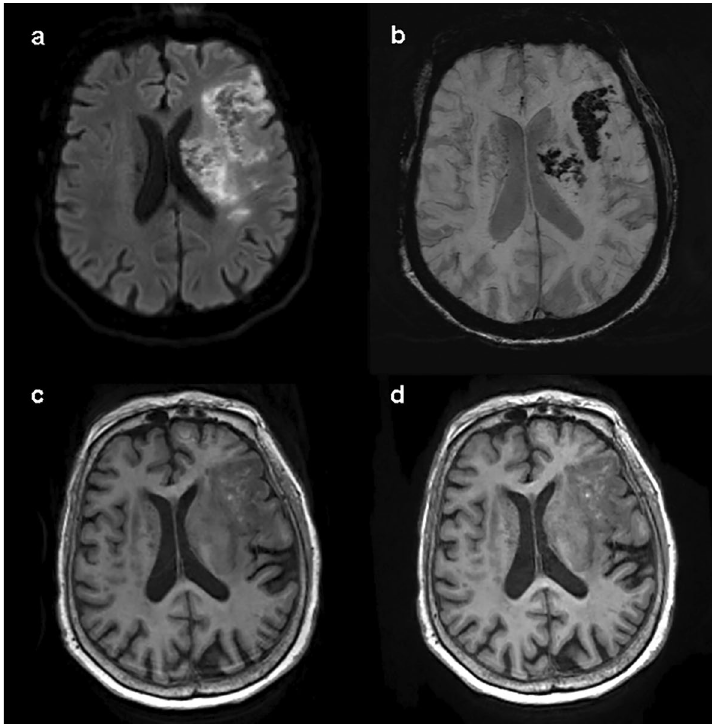
Figure 3. Subacute infarction on conventional and wave-CAIPI MPRAGE. An 87-year-old woman with right-sided weakness 7 days ago. Subacute stage infarction with hemorrhagic transformation in the left middle cerebral artery territory diagnosed on diffusion-weighted image ( a ) and susceptibility-weighted image ( b ). Both conventional pre-contrast 3D T1 MPRAGE ( c ) and wave-CAIPI MPRAGE ( d ) show parenchymal swelling with several tiny hyperintense dots suggesting hemorrhagic transformation foci in the left middle cerebral artery territory. MPRAGE magnetization-prepared rapid gradient echo, wave-CAIPI wave-controlled aliasing in parallel imaging.